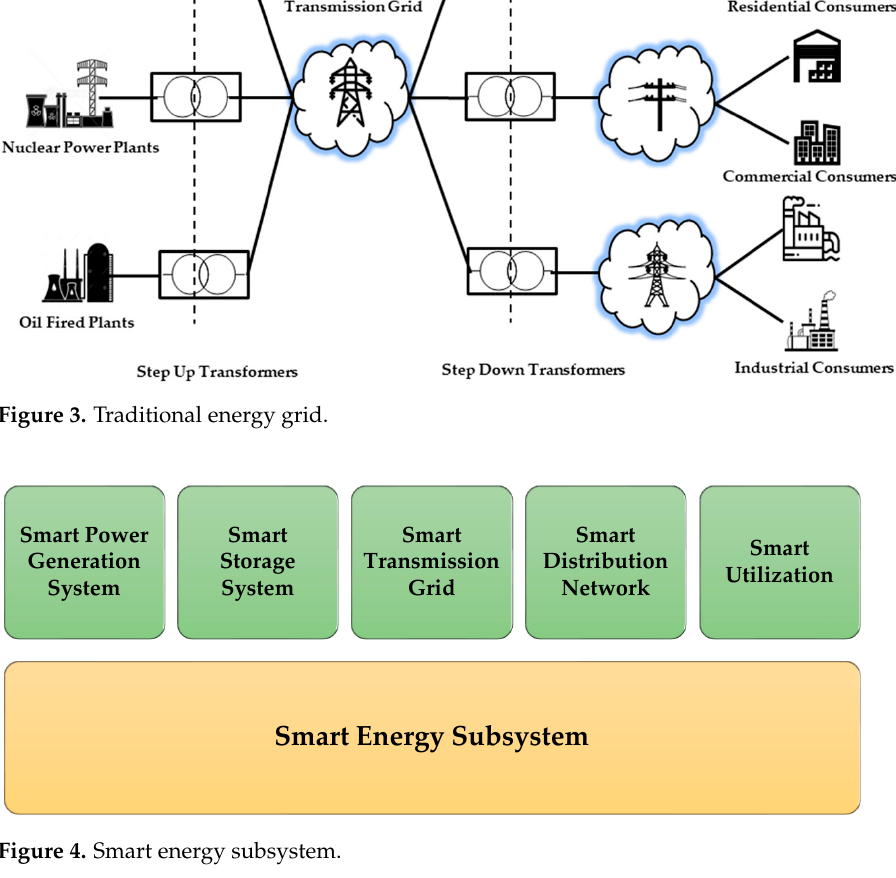
Figure 4. Smart energy subsystem.